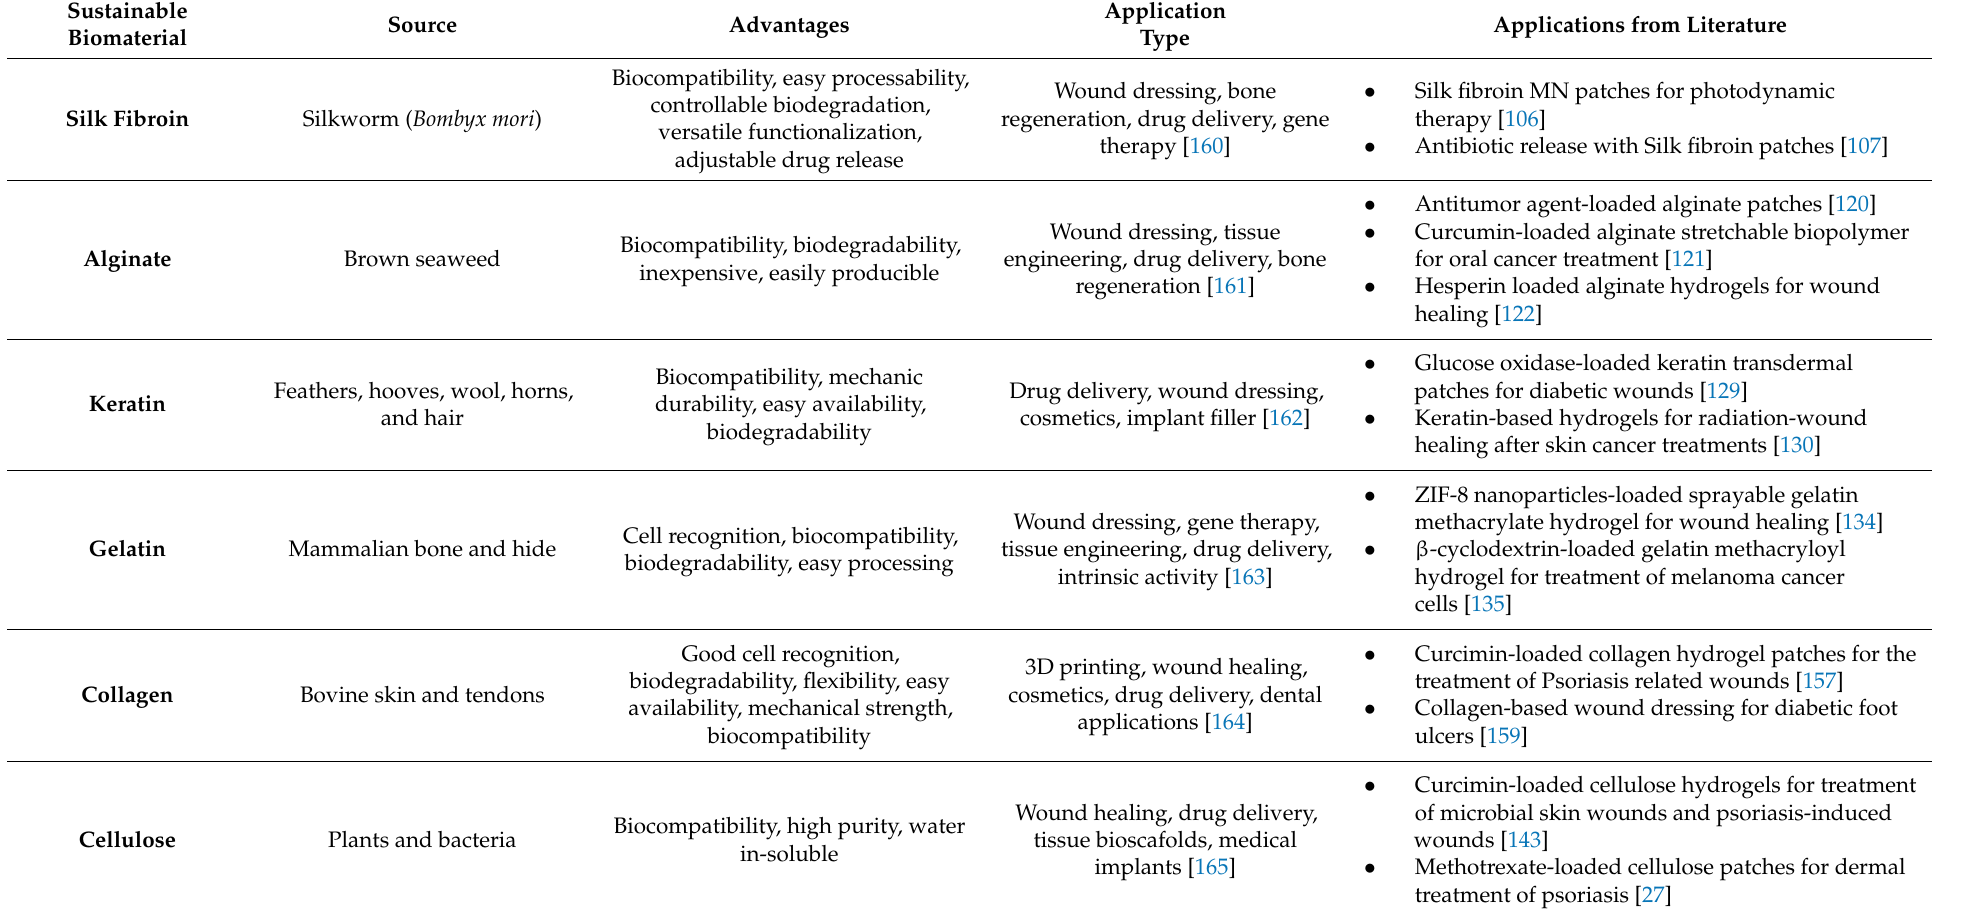
Table 4. Natural polymers for patches with their sources, advantages, and application